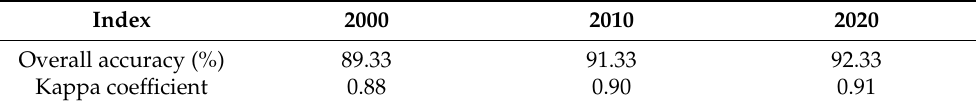
Table 2. Classification